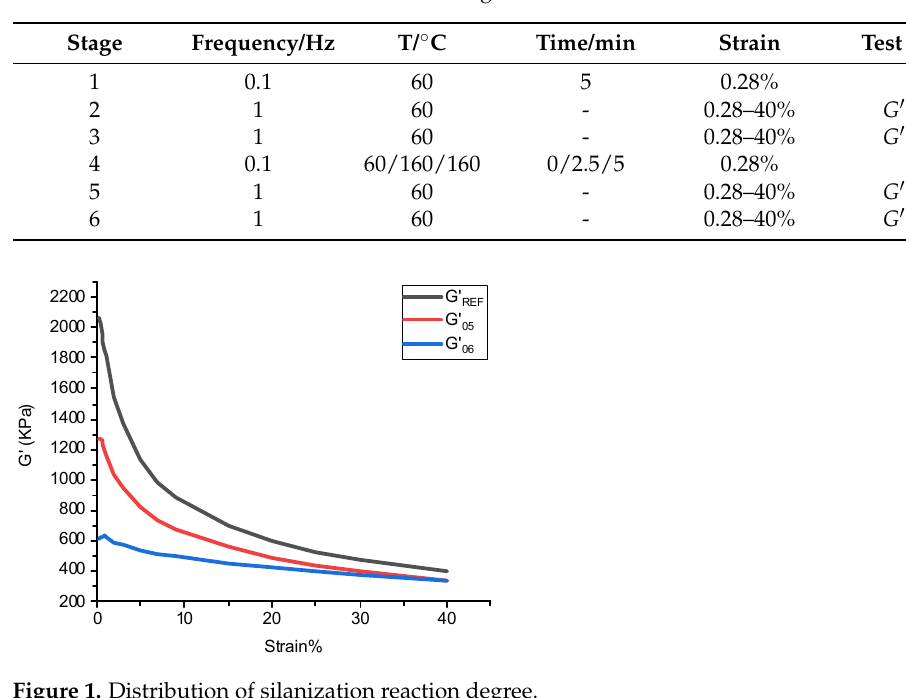
Figure 1. Distribution of silanization reaction degree.